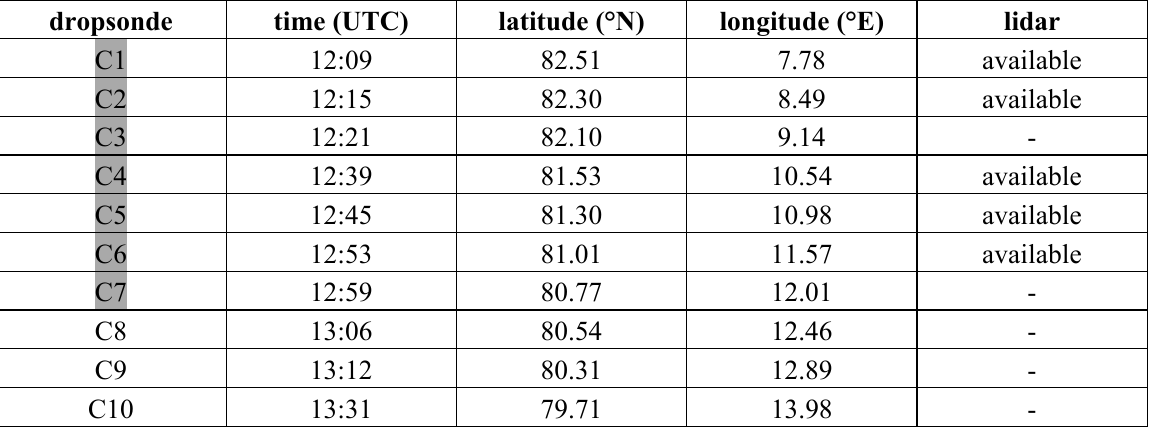
Table 3. Launch times and locations of the dropsonde measurements on 6 April 2009. The sondes used for case study C are highlighted in gray.